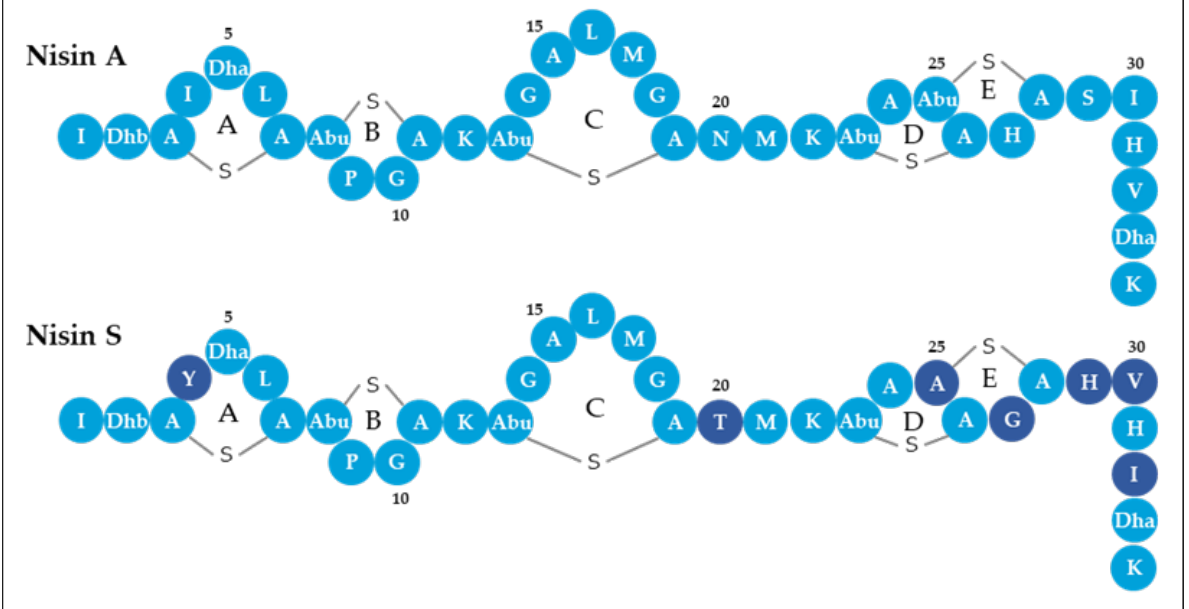
Figure 6. Predicted structure of the novel nisin S variant, using the deduced nisin A structure as a template. Post-translational modifications are indicated as follows: (Dha) dehydroalanine, (Dhb) dehydrobutyrine, (A-S-A) lanthionine, and (Abu-S-A) 3-methyllanthionine. Nisin rings are indicated as A, B, C, D, and E. Numbers indicate amino acid position. Differences in amino acids are shown as dark blue.